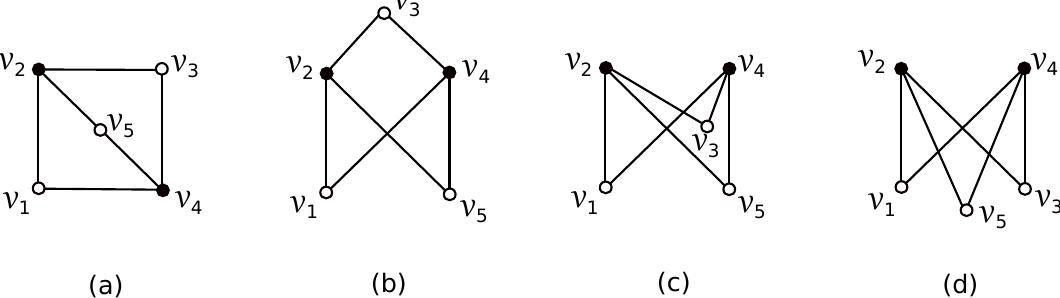
Figure 1. Four possible non isomorphic drawings of the graph K 2,3 . ( a ) the planar drawing of K 2,3 ; ( b ) the drawing of K 2,3 with one crossing on edges of K 2,3 ; ( c ) the drawing of K 2,3 with cr D ( K 2,3 ) = 2; ( d ) the drawing of K 2,3 with cr D ( K 2,3 ) =